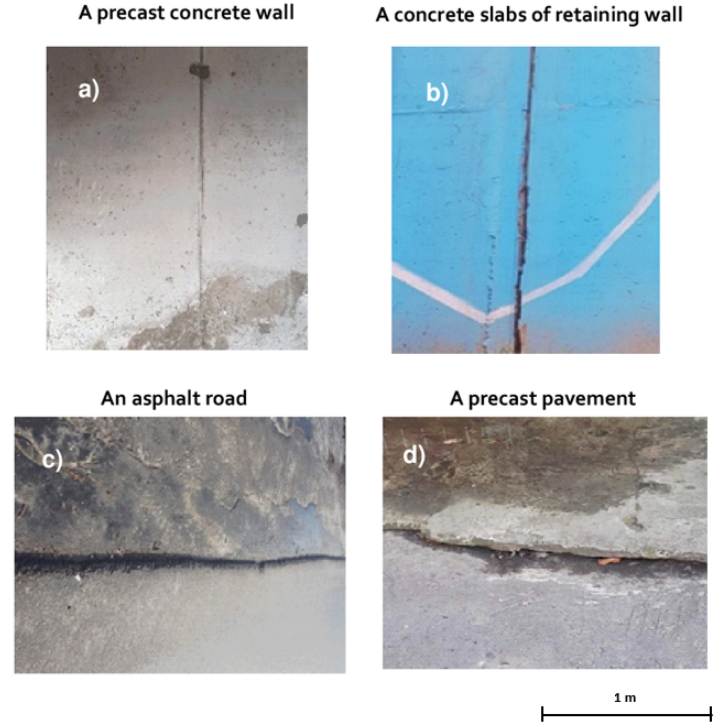
Figure 4. The fragments of the real objects measured using Terrestrial Laser Scanning (TLS).